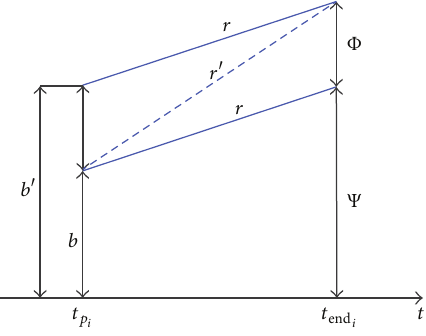
Figure 7: Service model of a HCCA centralized scheduler +